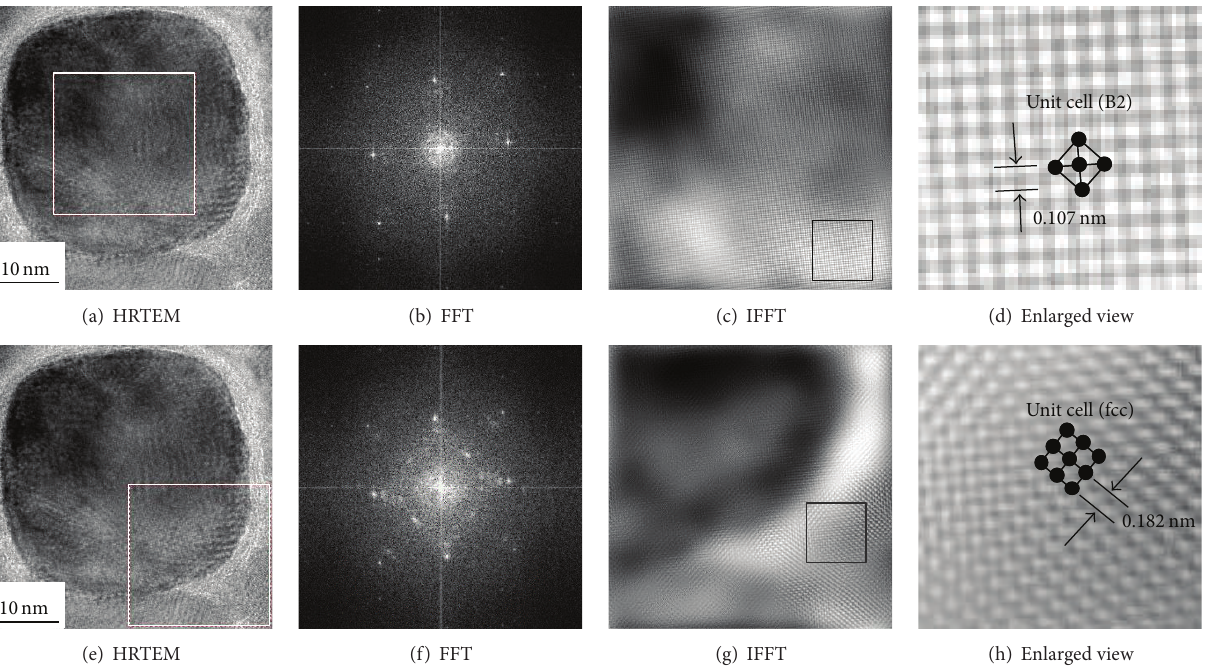
Figure 4: HRTEM, FFT, and IFFT images of Cu-1.8at%Fe-1.2at%Co.